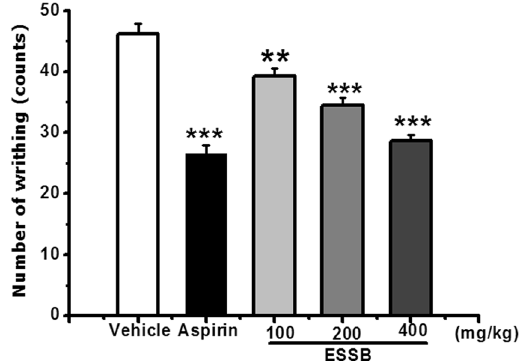
Figure 2. Analgesic effect of EESB on acetic acid-induced writhing response in mice. Results are expressed as mean ± SEM (n = 10). * P < 0.05, *** P < 0.001 vs . vehicle.